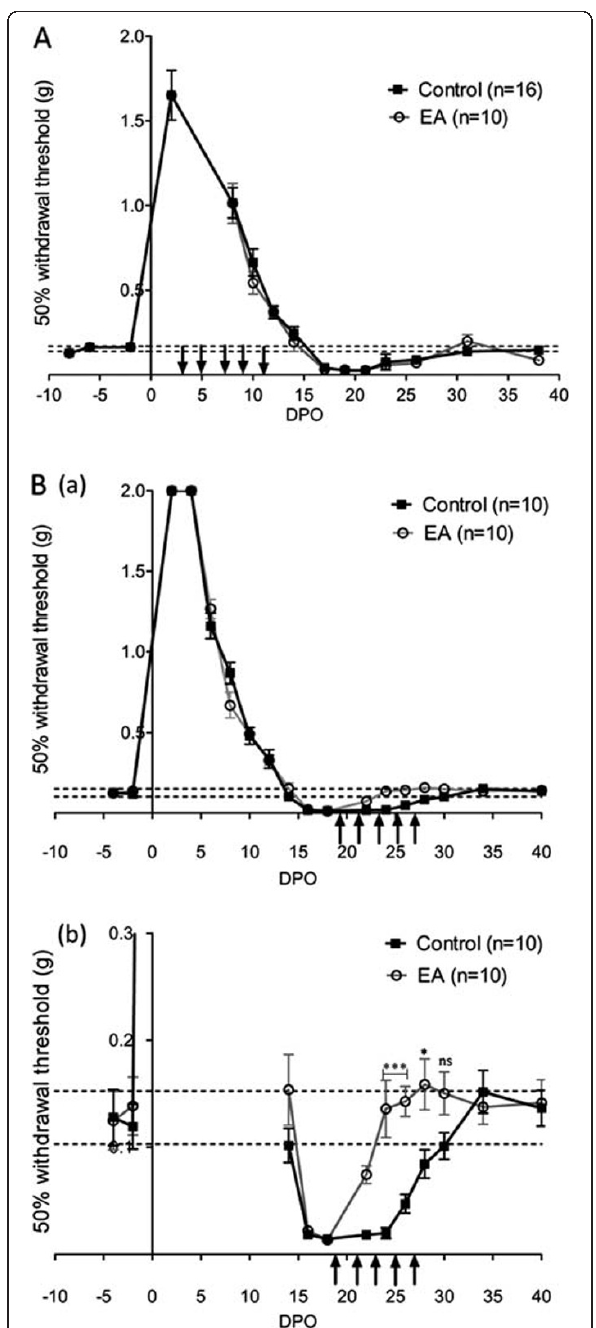
Figure 1 Analysis of mechanical sensitivity recovery. ( A ) Time for recovery of sensitivity to a mechanical stimulus using von Frey filaments. The withdrawal threshold (T50) is shown before and after left sciatic nerve crush injury. Vertical arrows indicate electro- acupuncture (EA) application, every two days for 15 min from 3 to 11 DPO (group 1). n is the number of mice in each group; values of T50 for the two groups were pooled before crush injury (n=26). (DPO: day post operation). ( B ) (a) Effects of electro-acupuncture applied at the moment of pain development from 19 to 27 DPO (group 2). In (b) enlarged view of the period of pain-related symptoms shown in ( a ). * p<0.05, *** p<0.001 (ANOVA).